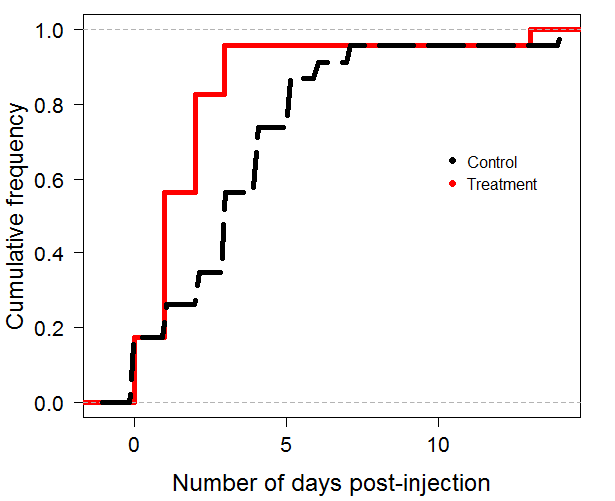
Figure 2. Cumulative fraction plot for Kolmogorov-Smirnov comparison of nurse bees treated with 1 microliter of insulin (solid line) and sham control nurse bees (dashed